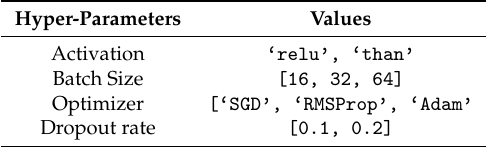
Table 5. Hyper-parameters used in grid search for the BiLSTM + CNN model.